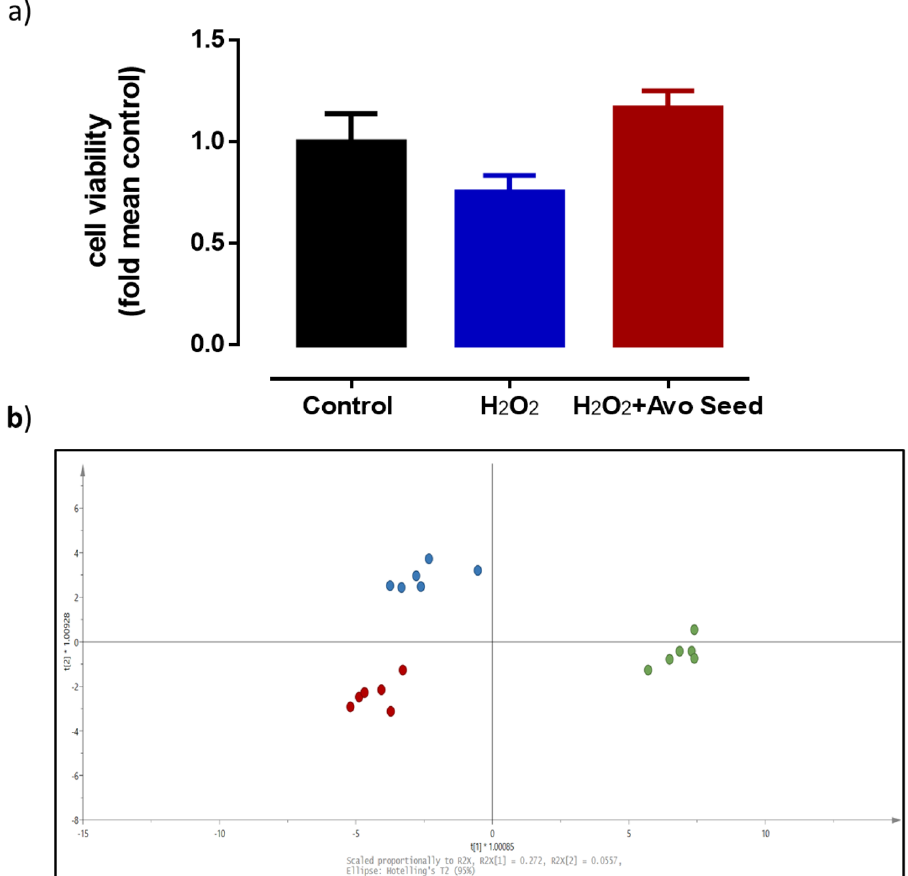
Figure 4. Effects of avocado seed extracts treatment in HMEC-1 cells under oxidative stress conditions. ( a ) Cytoprotective effects of avocado seeds extracts on H 2 O 2 -stimulated HMEC-1 cells. ( b ) OPLS score plot of LC/MS lipids profile of avocado seeds extracts treated cells, Green: Control, Blue: H 2 O 2 only, Red: H 2 O 2 and avocado seeds extracts. Data is presented as mean ± SD, n =